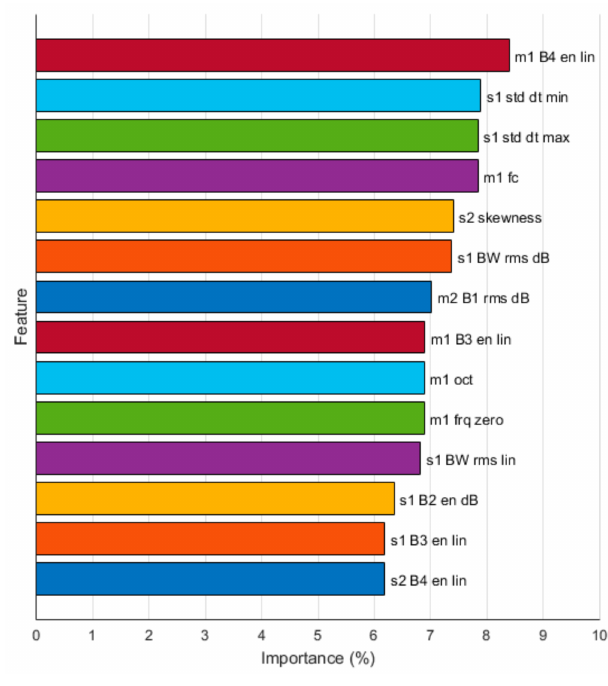
Figure 8. Top-15 features.